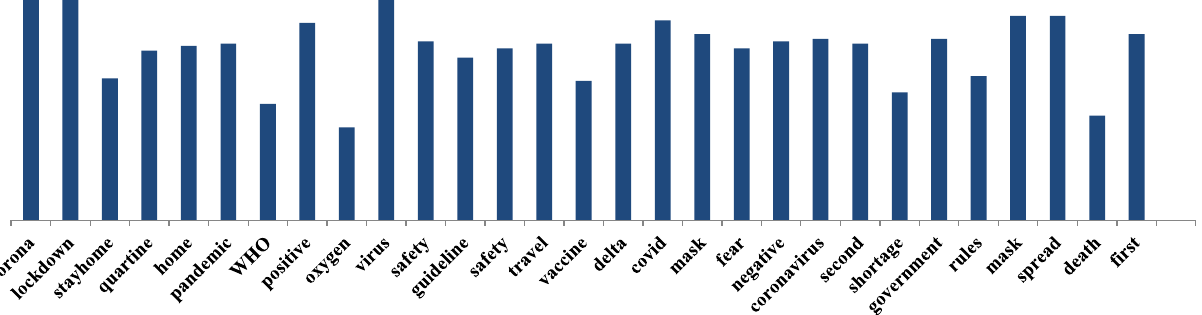
Figure 10. Top frequently used words which are most commonly discussed during the pandemic